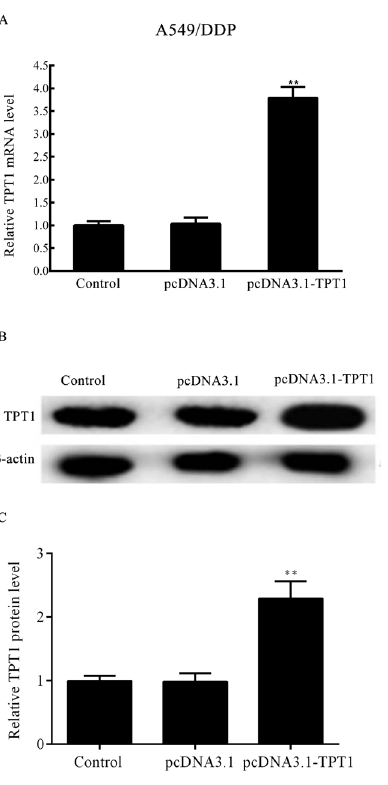
Figure 5: The expression level of TPT1 mRNA and protein in different groups. Relative TPT1 mRNA expression level in different groups measured by RT-qPCR assay. (B and C) Relative protein expression level of TPT1 in different groups measured by western blot assay. **P<0.01, pcDNA3.1-TPT1 vs pcDNA3.1 group. Control, un-treated